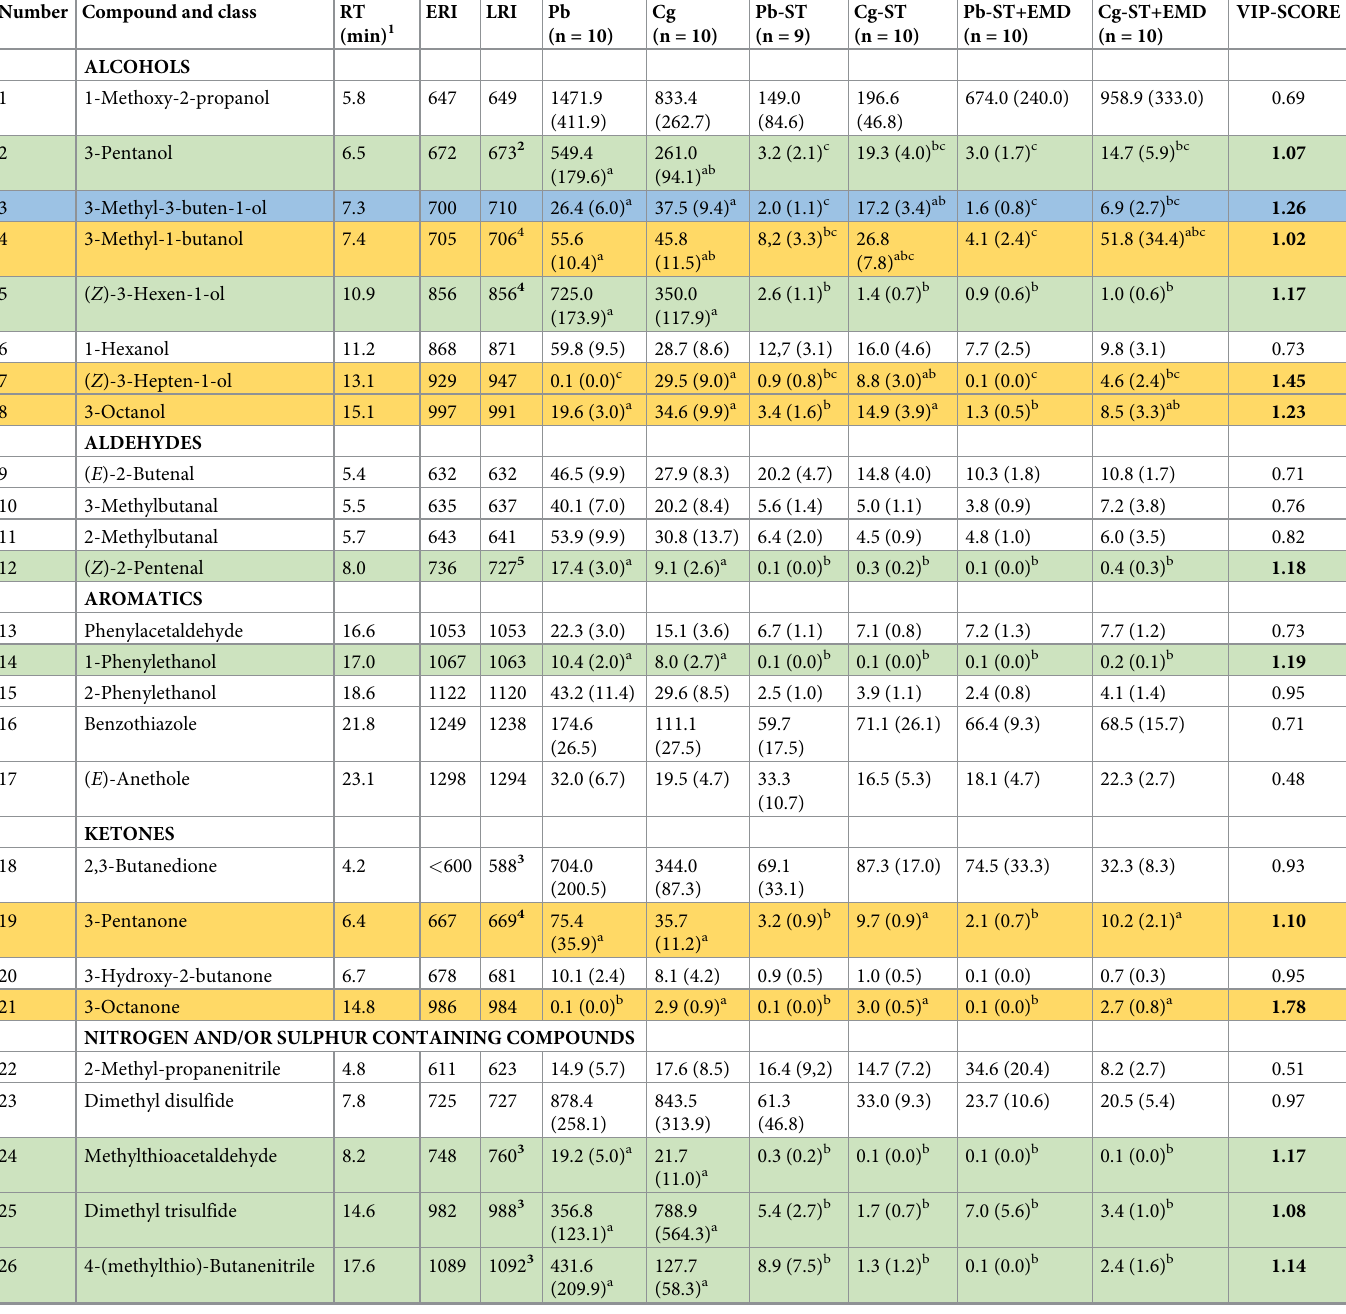
Table 1. Volatile compounds (tentative identification) detected in the headspace of untreated, starved or starved then external microbiome disrupted unparasitised or C . glomerata parasitised caterpillars ( P . brassicae ). Only those compounds have been included that were present in all replicates of at least one treatment. Amounts of individual compounds are given as the average of peak height /10 4 (SE). Variable Importance in the Projection (VIP) values for the OPLS-DA are also given. Bold face VIP scores are higher than 1 and are considered as the most influental VOCs for separation of the treatments as shown in Fig 3. Statistical differences among treatments for compounds with VIP score > 1 are indicated with superscript letters based on Kruskal-Wallis tests with Dunn’s test for multiple comparisons including a Bonferroni correction. Compounds in green are correlated with the presence/absence of frass and compounds highlighted in yellow are correlated with parasitism status, compound in blue is not correlated to either of these. Abbreviations used: Cg = Untreated parasitised caterpillars; Cg-ST = starved parasitised caterpillars; Cg-ST+EMD = starved then external microbiome disrupted parasitised caterpillars. Pb = Untreated unparasitised caterpillars; Pb-ST = starved unparasitised caterpillars; Pb-ST+EMD = starved then external microbiome disrupted unparasitised